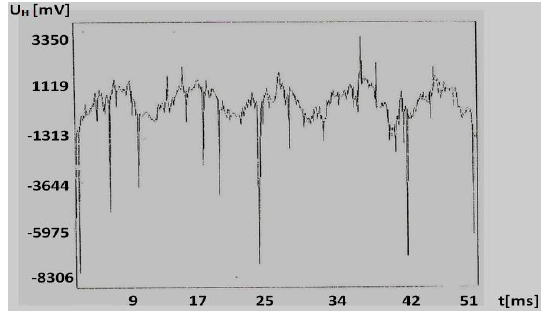
Figure 13. Hall voltage versus time in the case of the shorting of two commutator sectors, Hall sensors fixed on the rotor, loaded starter.